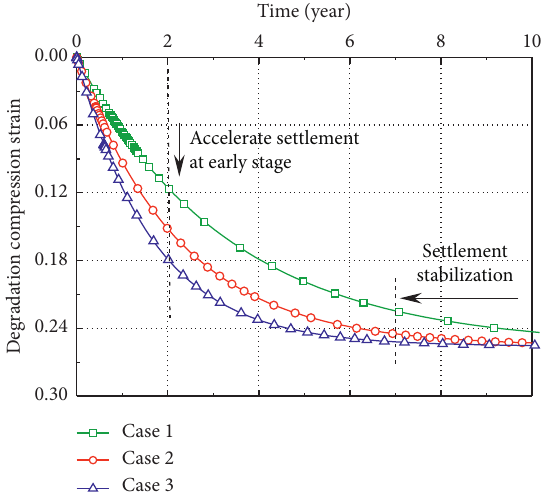
Figure 6: Degradation compression for landfill under different recirculation